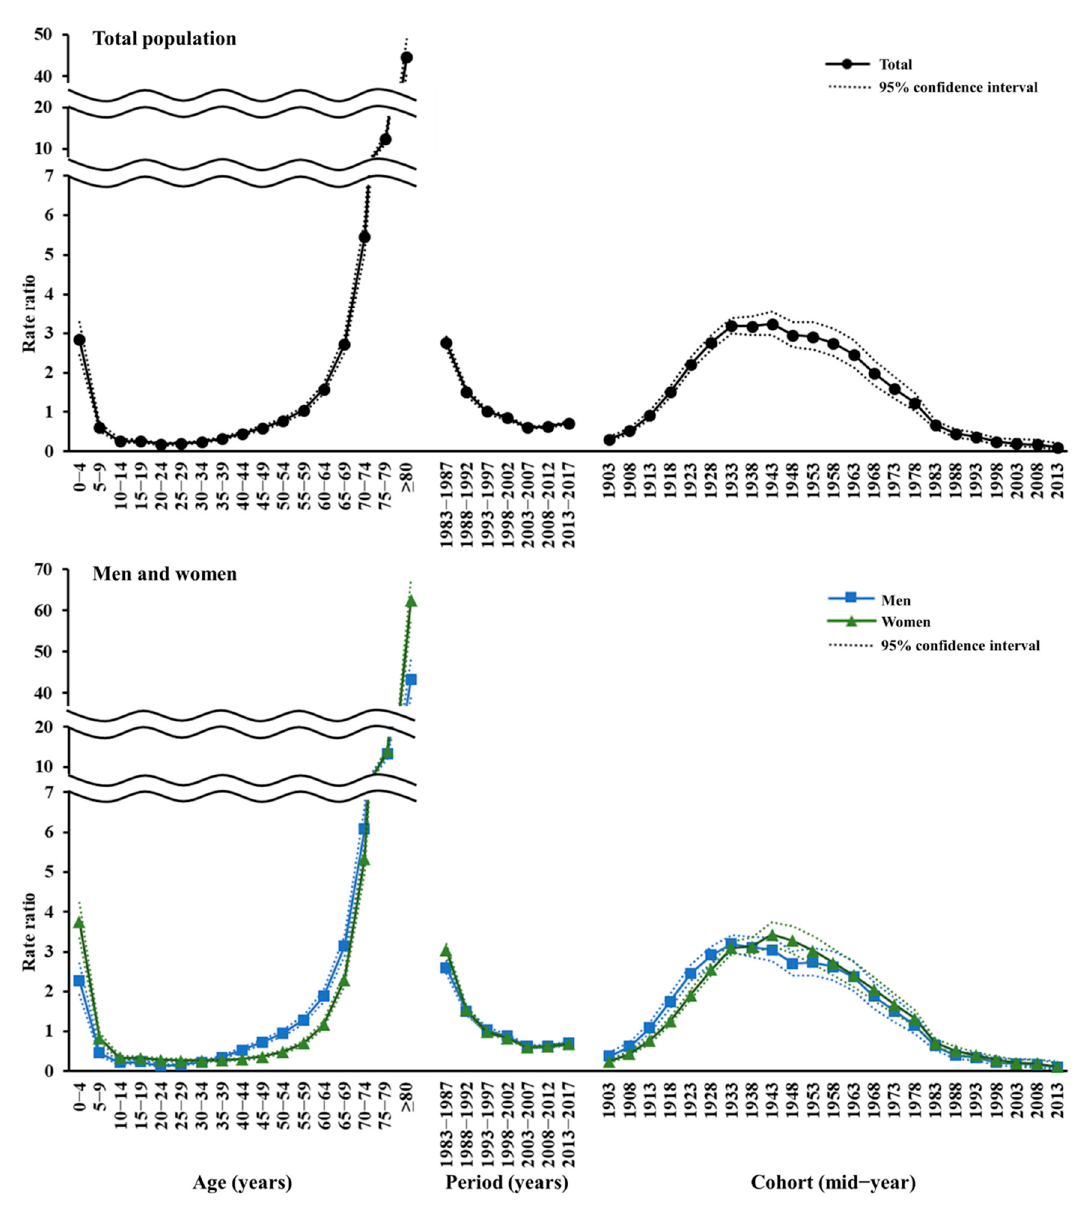
Figure 2. Age, period, and cohort effects on infectious disease mortality in South Korea from 1983 to 2017.